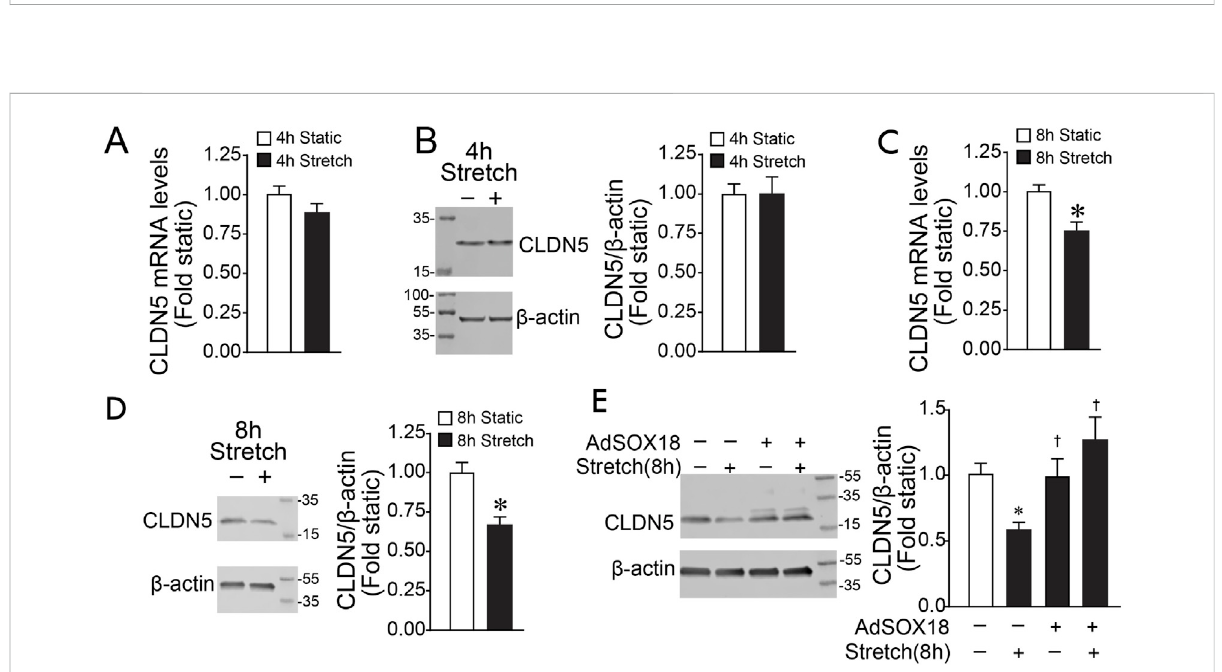
FIGURE 3 Exposing human lung microvascular endothelial cells to pathologic cyclic stretch reduces Claudin-5 expression. HLMVECs were exposed to 18% cyclic stretch. HLMVEC lysates were analyzed by immunoblot using a speci fi c Claudin-5 antibody. qRT-PCR analysis showed that 4 h of cyclic stretch did not signi fi cantly reduce Claudin-5 expression levels (A) , which matches the densitometric analysis of Claudin-5 protein levels (B) . By contrast, we found a signi fi cant decrease of CLDN5 mRNA after 8 hrs of cyclic stretch at 18% (C) , re fl ecting the densitometric analysis showing that Claudin-5 protein levels are signi fi cantly decreased (D) . Densitometric analysis showed that overexpression of SOX18 prevents the cyclic stretch-dependent Claudin-5 decrease in HLMVECs (E) . * p < 0.05 versus Static, † p < 0.05 versus Stretch. N = 4 (B) ; N = 6 (A,C,D) ; N = 14 – 20 (E)